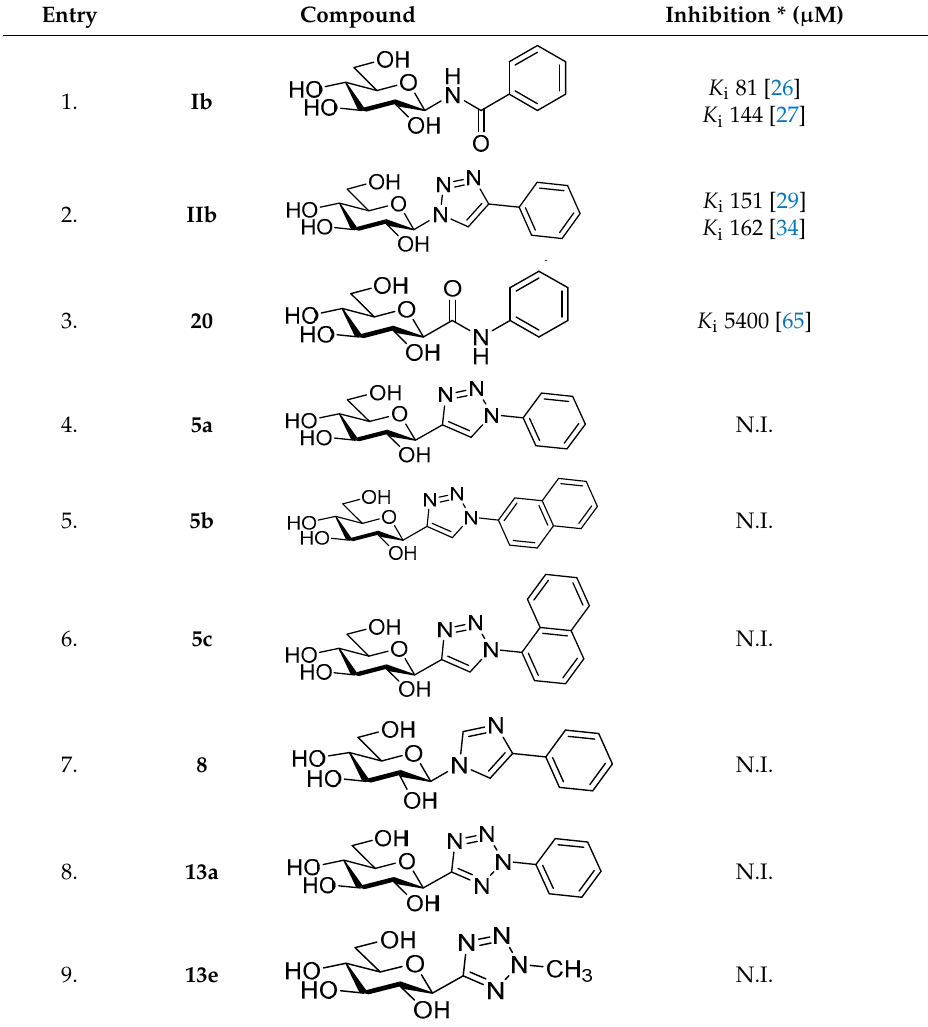
phosphorylase b (RMGP b ).